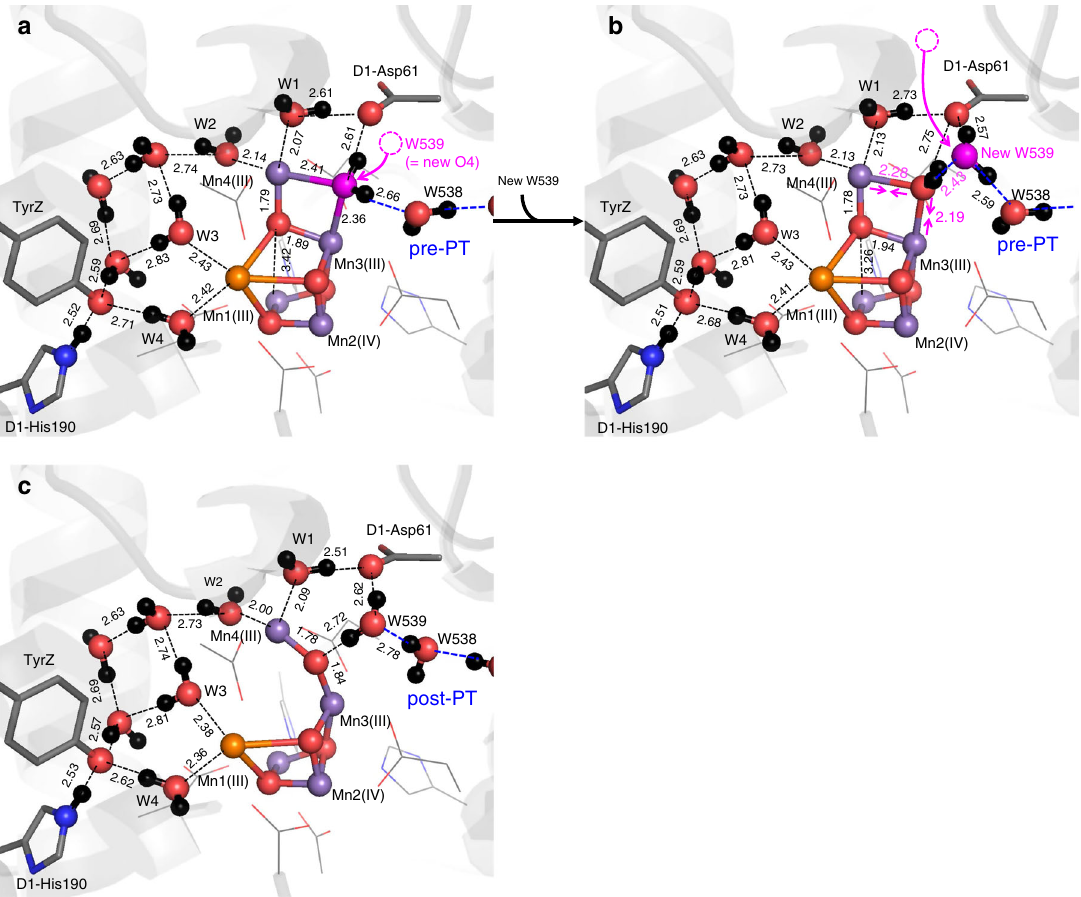
Fig. 6 QM/MM geometries in the O4-depleted and O5-depleted PSII proteins. a Formation of the Mn3 – O W539 and Mn4 – O W539 bonds in response to incorporation of H 2 O at W539 into the O4 site of the O4-depleted Mn 4 CaO 4 cluster. b Shorting the Mn3 – O W539 and Mn4 – O W539 bonds in response to incorporation of H 2 O into the vacant W539 site. c QM/MM geometries in the O5-depleted PSII. (Mn1, Mn2, Mn3, Mn4) = (III, IV, III,